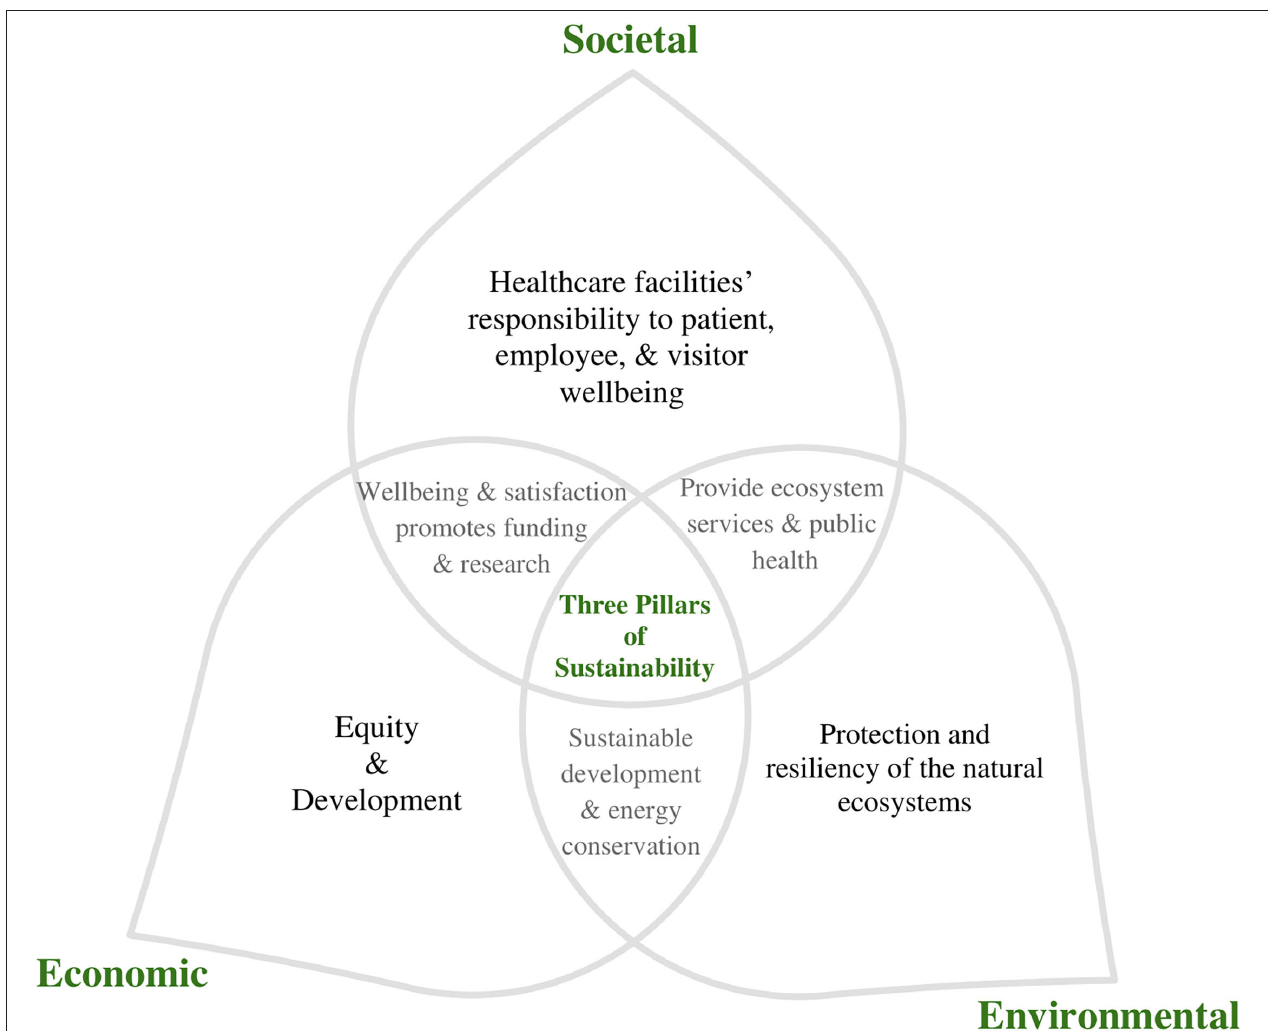
FIGURE 1 | Connecting the benefits of the three pillars of sustainability.